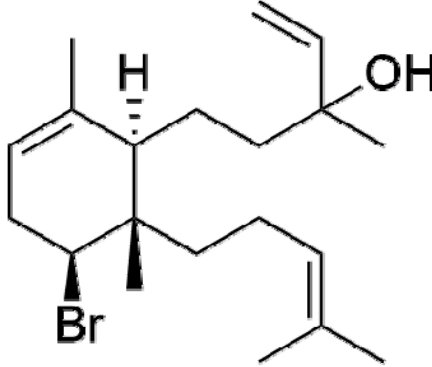
Figure 1. Chemical structure of sphaerodactylomelol.